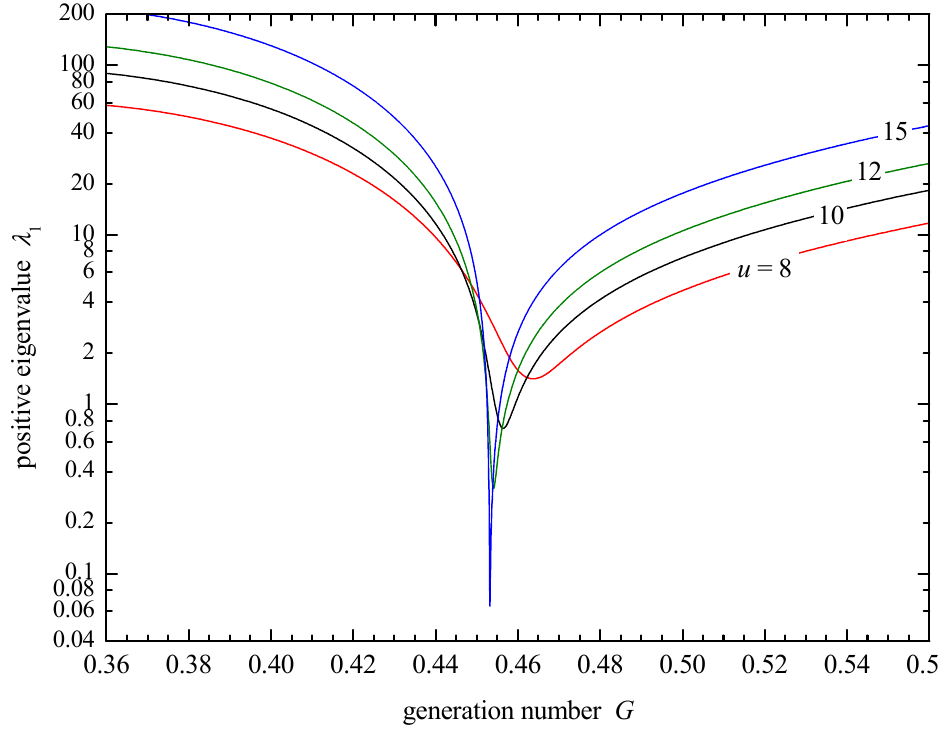
Figure 14. The positive eigenvalue 𝜆 1 as a function of u.